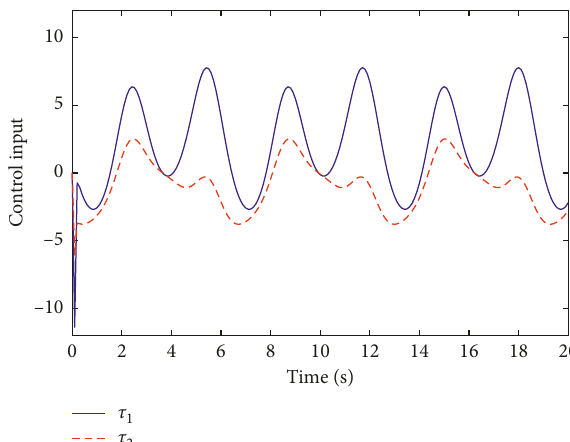
Figure 6: Single NN-based control inputs.